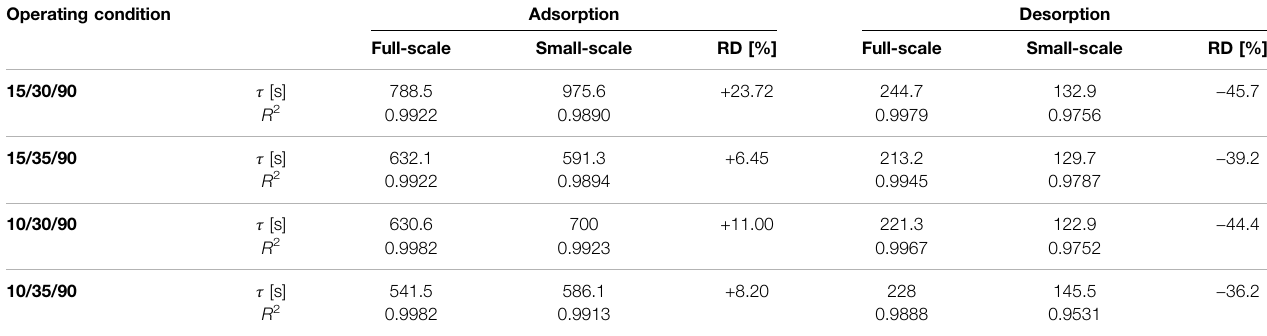
TABLE2| Timeconstantoftheexponential fi tting( τ )andits( R 2 )valueoftheadsorptionanddesorptionkineticdataobtainedateachsetofoperatingconditionsfortheAPHE (Full-scale) and its representative adsorbent sample